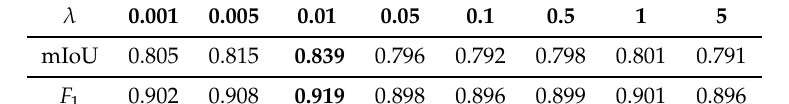
Table 7. The performance output for different parameters λ of normalized cut combined with the partial loss function in dataset 1 .